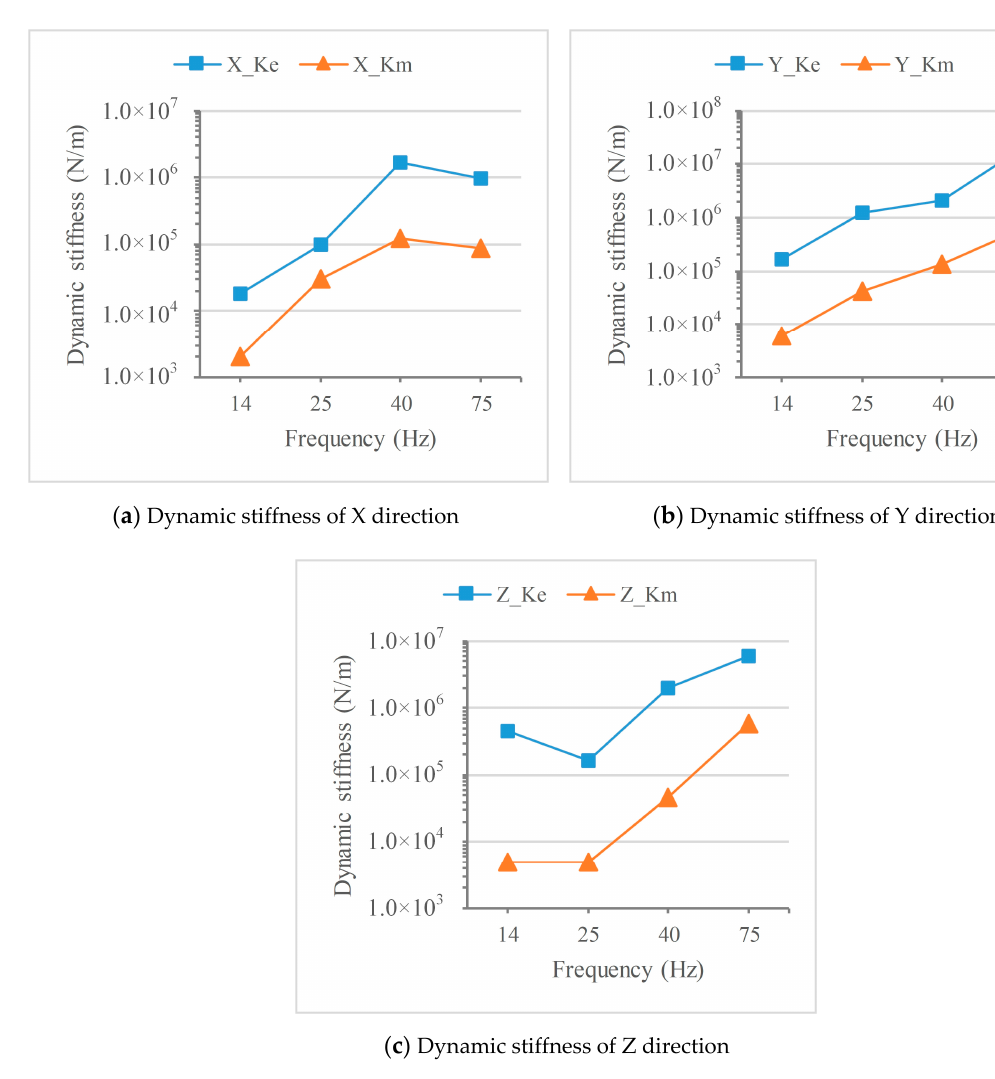
Figure 8. Dynamic stiffness distributions under two calculation approaches.